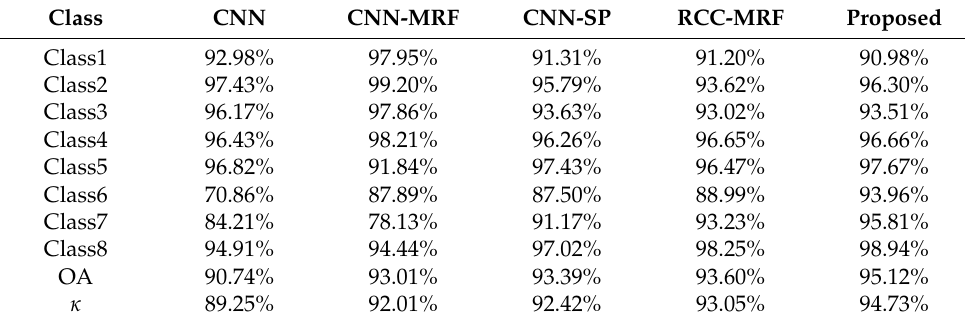
Table 3. Accuracies of classification on synthetic SAR